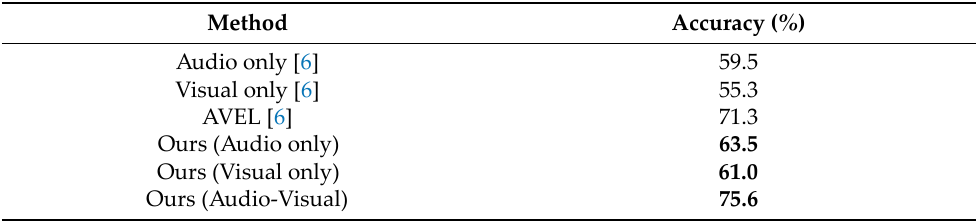
Table 2. Evaluation of AV‑BT. Our results are in bold . Note that we use no extra module for fusion at this point, but simply add audio and visual features together to make classifications. For comparison, the result of AVEL in [6] is obtained by end‑to‑end fully supervised training and they used the same strategy of addition before